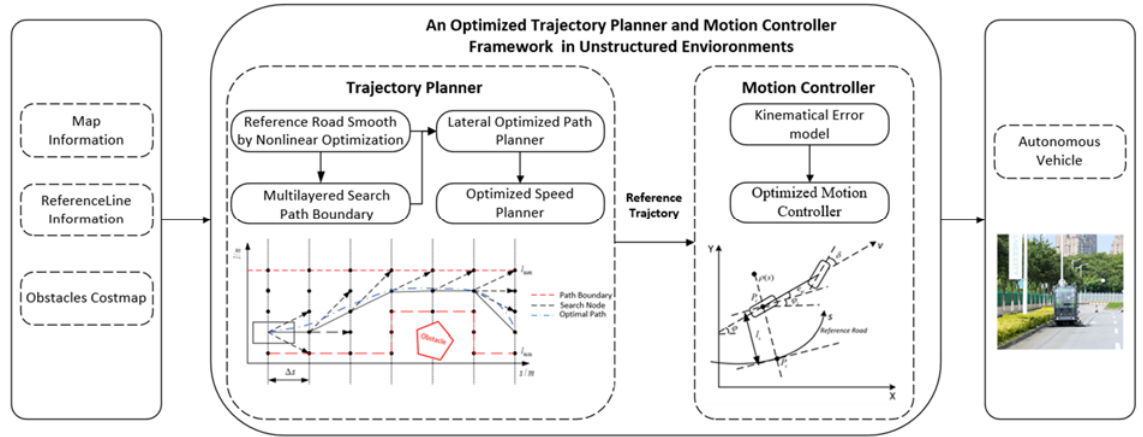
Figure 1. Trajectory planner and motion controller